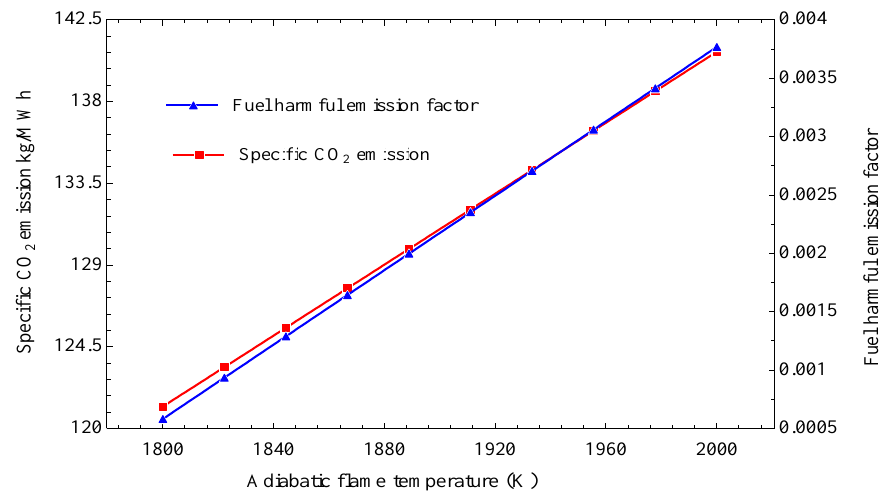
Figure 4. Effect of adiabatic flame temperature on CO 2 emission and F EF. Figure 4. E ff ect of adiabatic flame temperature on CO 2 emission and F EF.